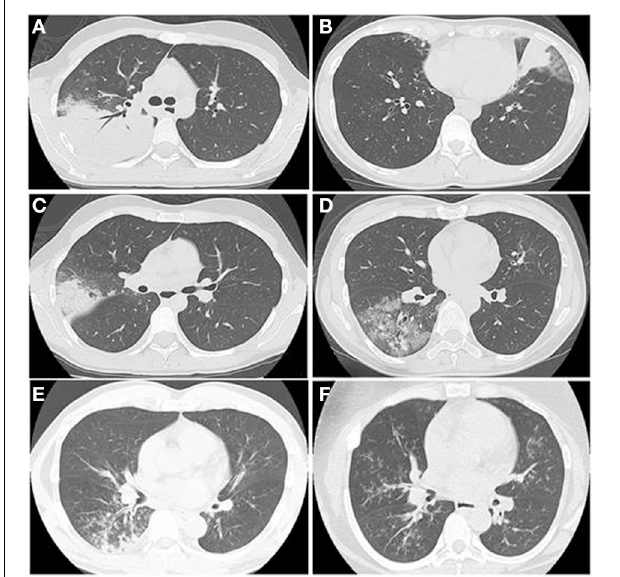
FIGURE 8 | The HRCT findings of Mp pneumonia are characterized as (A) consolidation with air bronchogram surrounded by a crazy paving appearance, (B) consolidation with reticular shadow, (C) consolidation with GGO, (D) GGO with interlobular septal thickening, crazy paving appearance, (E) bronchial wall thickening with centrilobular nodules, (F) diffuse centrilobular nodules.